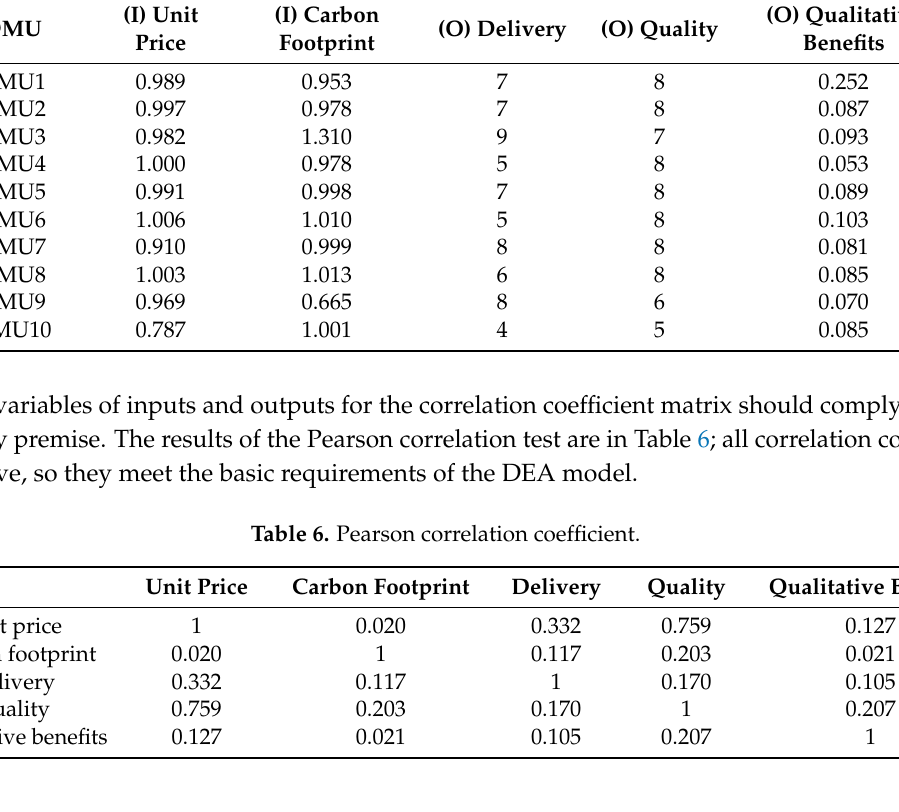
Table 6. Pearson correlation coefficient.